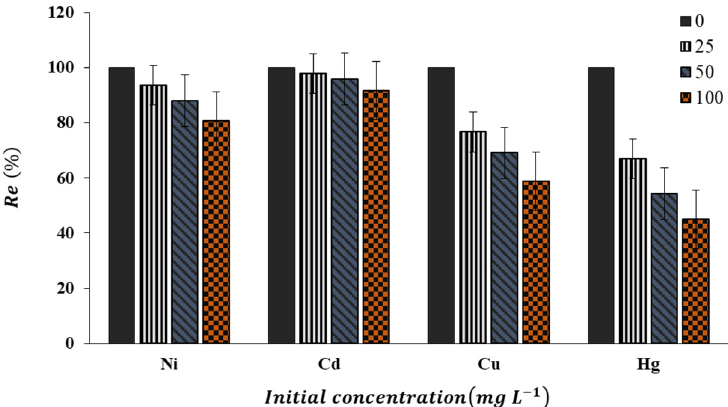
Figure 13. Effect of competing ions on Pb(II) removal efficiency by nZVFe–RSAC.